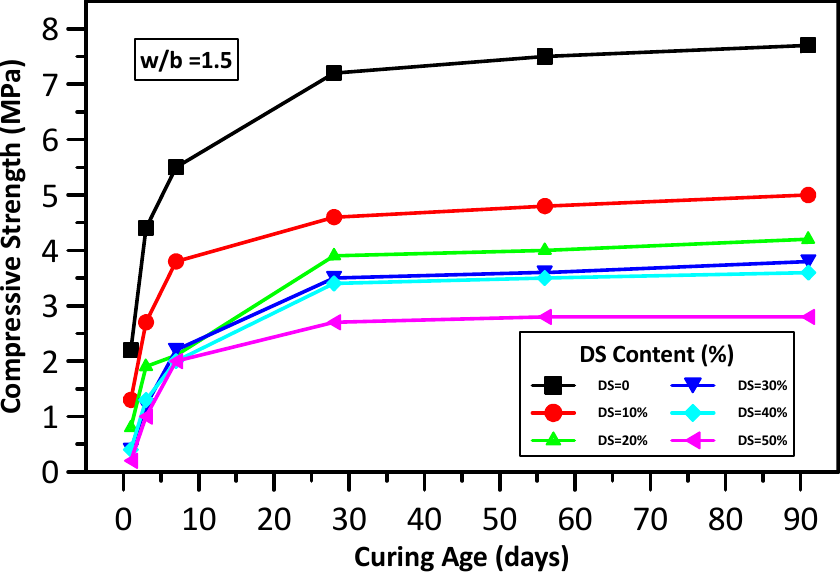
Figure 2. The relationship between the curing age and compressive strength of the controllable low-